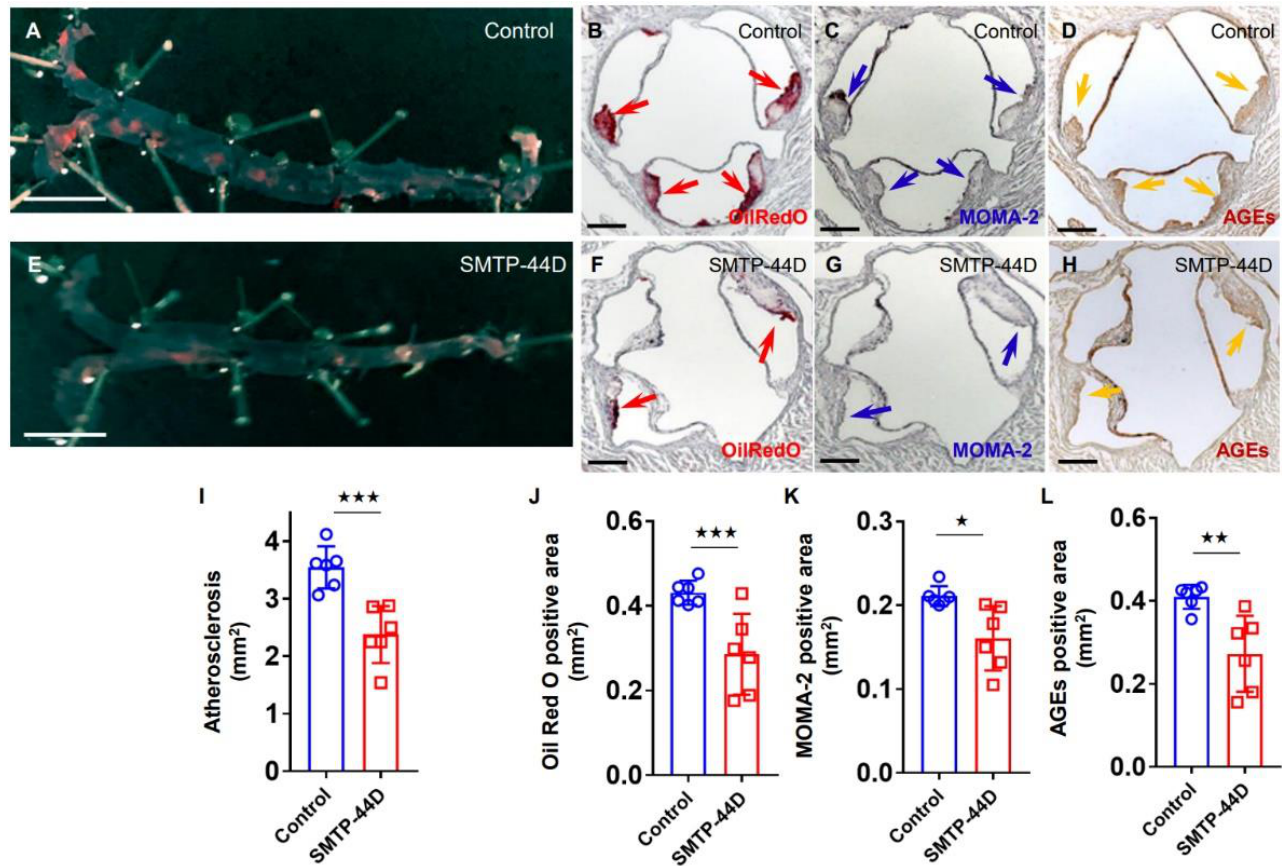
Figure 1. Effects of SMTP-44D on atherosclerotic lesions, macrophage infiltration, and accumulation of AGEs in the entire aorta and aortic roots in Apoe −/− mice administered with SMTP-44D or saline. ( A – H ) Representative images are shown. The aortic surface was stained with Oil red O. White scale bars correspond to a length of 5 mm. ( A , E ), while the aortic roots were stained with Oil red O ( B , F ), MOMA-2 ( C , G ), and AGEs ( D , H ). Magnification x40. Black scale bars correspond to a length of 200 µ m. Surface area of the atherosclerotic lesions ( I ), and the cross-sectional area of atheromatous plaque size ( J ), macrophage infiltration ( K ), and AGEs accumulation ( L ) in the aortic roots were quantified and shown as mean ± standard deviation. Number = 6 for each group. ★★★ p < 0.005, ★★ p < 0.01, and ★ p < 0.05 vs. saline-treated mice.